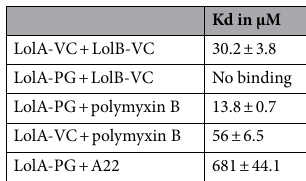
Table 1. ITC data for combinations of LolA, LolB, polymyxin and